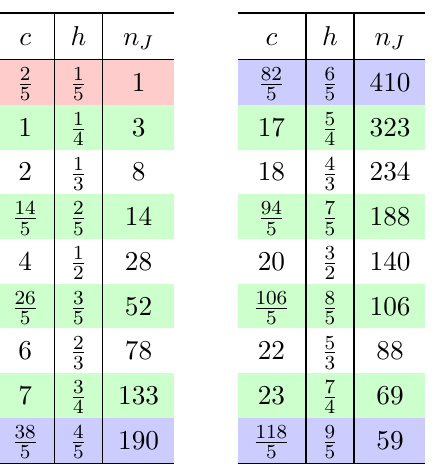
Table 4 . Potential ( d, ‘ ) = (2 , 0) (left) and ( d, ‘ ) = (2 , 2) (right) theories. Rows colored red denote theories which admit multiple vacuum interpretations. Here we have chosen a single possible interpretation, and n gives the number of spin-1 currents in that interpretation. Rows colored green J (blue) denote cases with a positive (negative) integer Verlinde